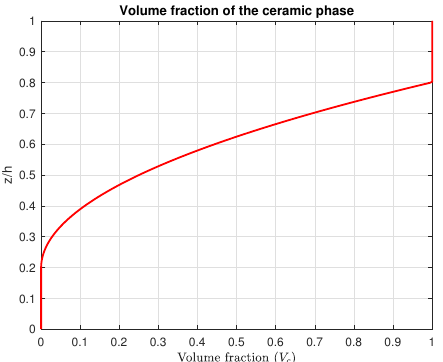
Figure 8. Third benchmark, volume fraction of the ceramic phase for a simply supported sandwich cylindrical shell with FGM ( p = 2) core.